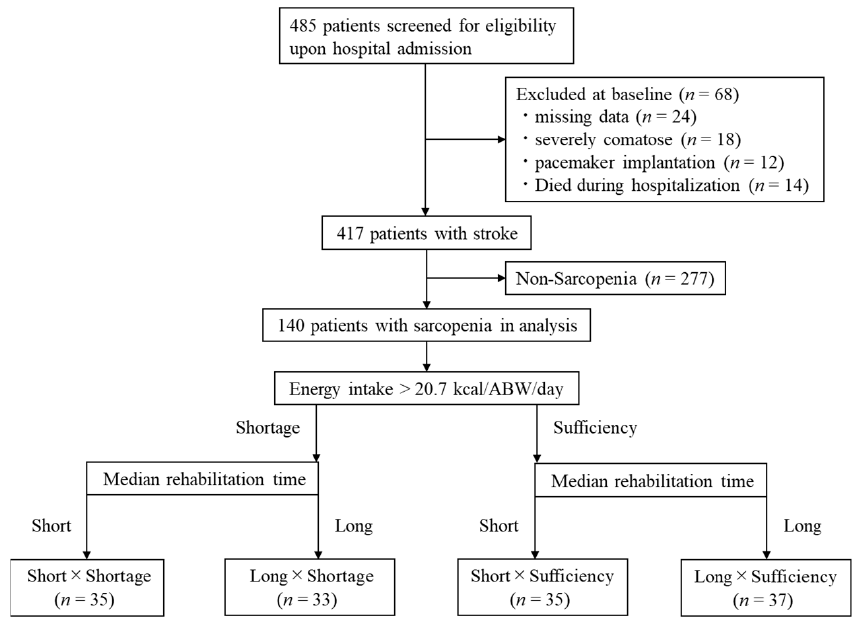
Figure 1. Flowchart of the study. ABW: Actual Body Weight.